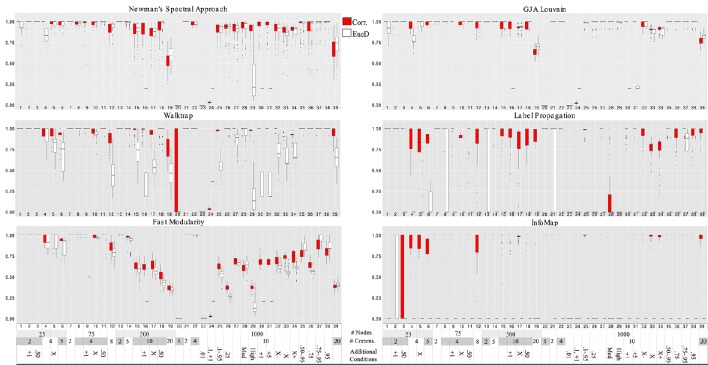
Hubert-Arabie adjusted Rand Index ARIHA for correlation and reflected euclidean distance matrices. Simulation numbers correspond to those described in Table 3. In the legend depicting the simulation parameters appended at the bottom of the graph, “Comms.” indicates communities; in the “Additional” row, numbers indicate the connectivity range (when not stated, it is 0.25–0.95); “X” indicates unequal group sizes, with “X−” indicating more small groups than large and “X+” indicating more large groups than small; “Med” and “High” indicate medium and high degrees of community overlap (i.e., correlation among communities), respectively. Infomap conducted on correlation matrices performed best for graphs with 25 nodes. Walktrap on correlation matrices outperformed the other methods for graph sizes ≥75 across the varied conditions. Walktrap and Infomap conducted on correlation matrices were the only approaches to not return false communities when there is only 1 community (Simulation #20).